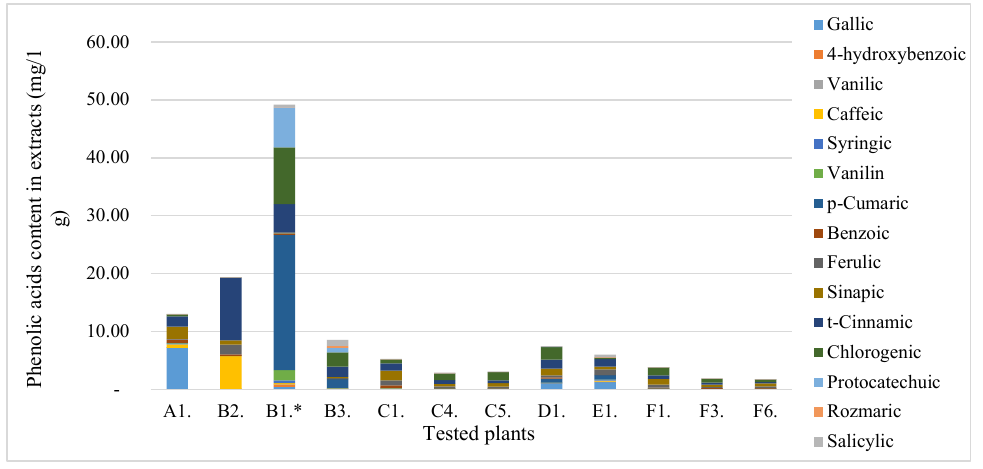
Figure 2. The content of phenolic acids in the plants tested. *—value for B1 × 10. Sterols are compounds important not only in the diet of humans and animals. The tested plant materials are rich in phytosterols, and the extraction method allows for the effective extraction of these compounds. The content of the essential phytosterols was, therefore, determined (Figure 3). Sea buckthorn berries had the highest phytosterols content, followed by beach rose. The rest of the plant material contained similar amounts of sterols, and the dominant one was beta-sitosterol. Carotenoids were another group of hydrophobic compounds found in the extracts. The concentration of these compounds was, on average, about 10 mg/1 g of extract. The value of approx. 20 mg/1 g of the extract was recorded for bitter melon and beach rose (Figure